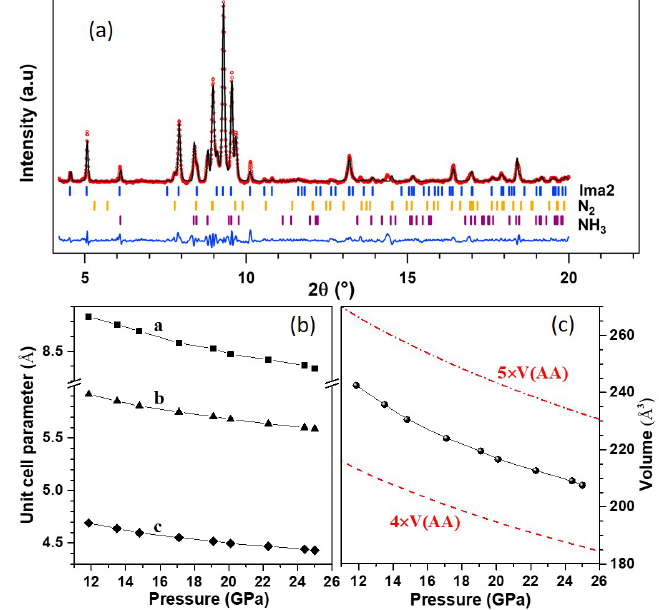
Figure 3. XRD pattern of the AA + N 2 sample at 20.1 GPa–300 K after the high P - T transformation. Panel ( a ) shows the three-phase Le Bail fit of the pattern using the Ima2 unit cell for phase A, (cid:101) -N 2 ( R-3c ) and NH 3 -V ( P2 1 2 1 2 1 ). The background has been subtracted for easier viualization. The red circles are experimental data, the black line is the Le Bail fit and the blue line is the fit residual. Ticks indicate the position of the Bragg peaks for each phase. The bottom panels show the unit cell parameters ( b ) and volume ( c ) of the Ima2 cell. The latter may be compared to the dashed and dash-dotted lines, representing, respectively, four and five times the volume of AA-II ( P2/c